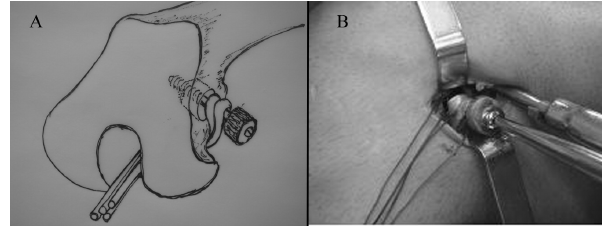
Figure 2 - Drawing (A) and picture (B) of the spongious screw with the metal washer and the bone washer being passed through the two tendon loops after countouring the lateral femoral condyle in an “over-the-top” fashion.